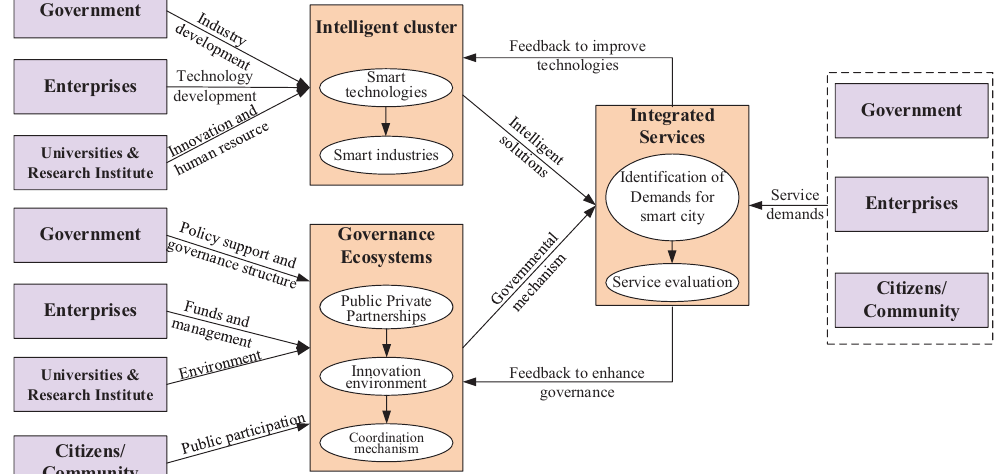
Figure 9. The policy suggestions to develop smart